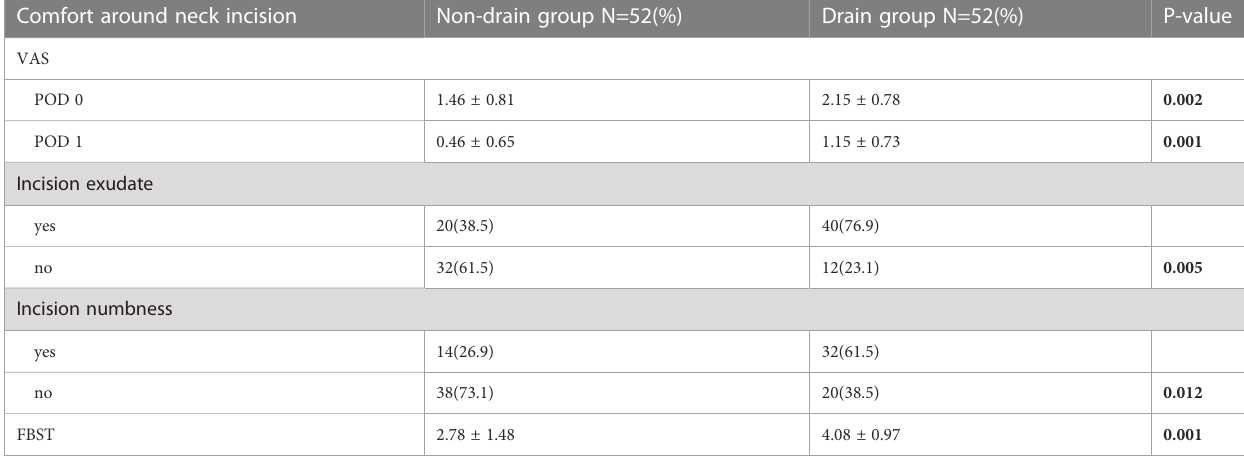
TABLE 4 Comparison of Comfort around neck incision between the non-drainage group and drainage group.